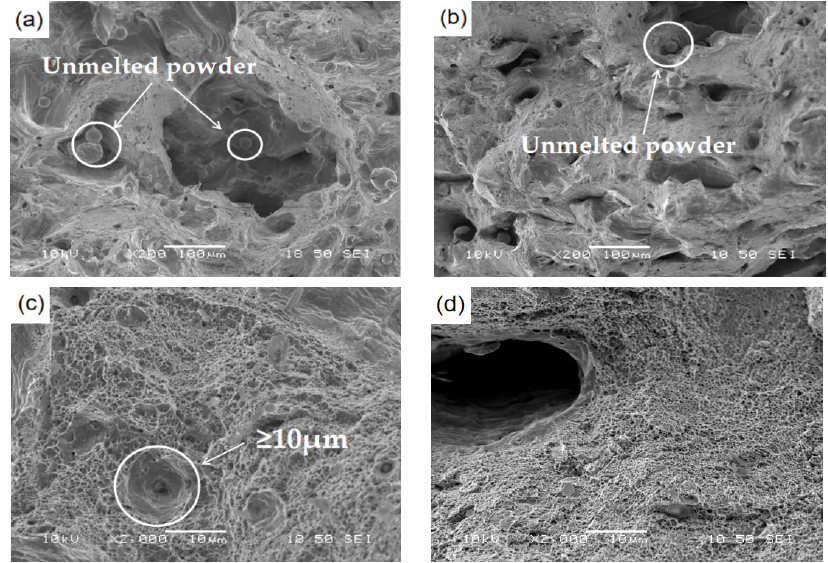
Figure 13. Photo of the microscopic topography at the fracture: ( a ) flat-printed sample 200×; ( b ) vertical-printed sample 200×; ( c ) flat-printed sample 200×; ( d ) vertical-printed sample 200× .